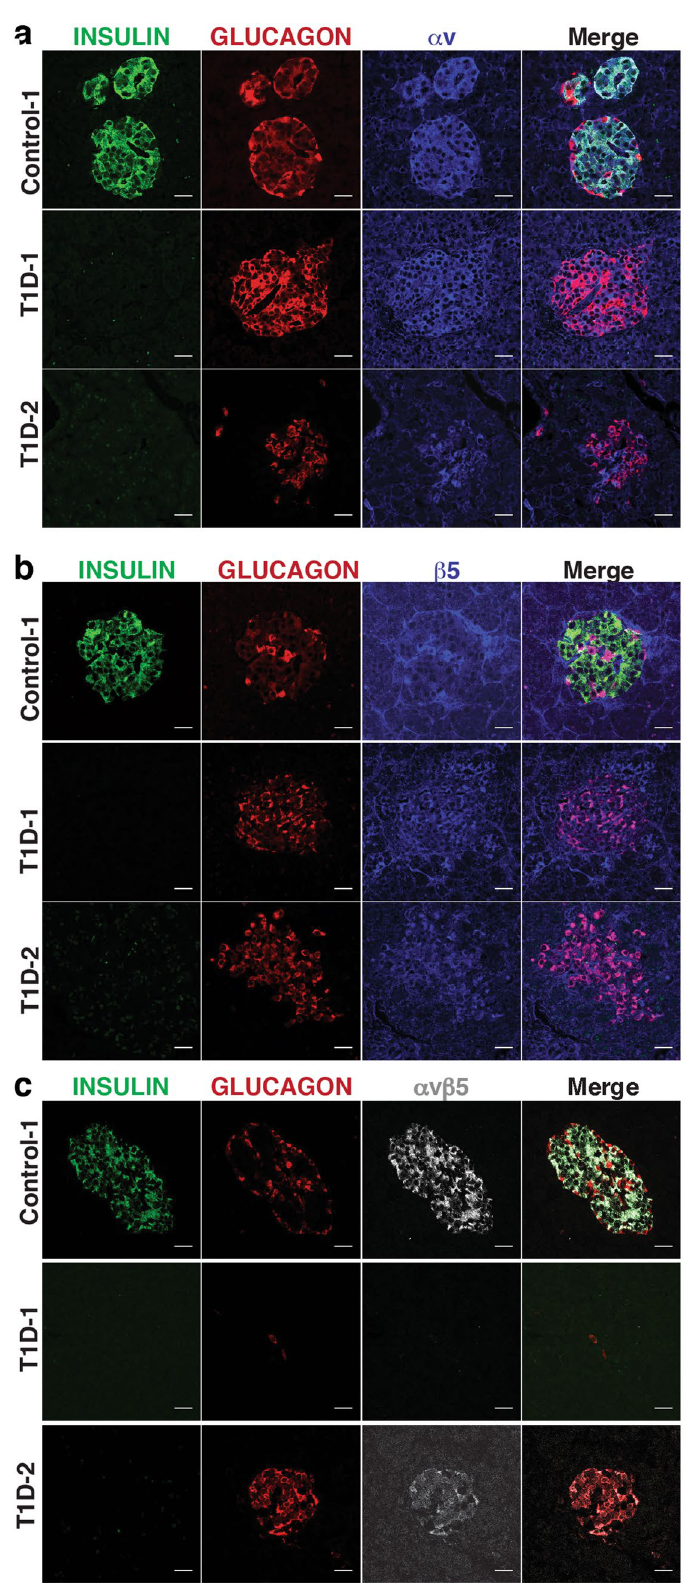
Figure 2. Expression of the integrin heterodimer αvβ5 and its component subunits in human pancreatic islets. ( a , b ) Immunofluorescence analysis of integrin subunits αv (a) and of β5 (b) expression in pancreatic sections representing control and T1D tissue donors co-stained with antibodies recognising INSULIN (green) and GLUCAGON (red). ( c ) Immunofluorescence analysis of αvβ5 heterodimer formation (grey) in pancreatic sections representing control and T1D tissue donors, co-stained with antibodies recognising INSULIN (green) and GLUCAGON(red). Scale bars for all images are 25